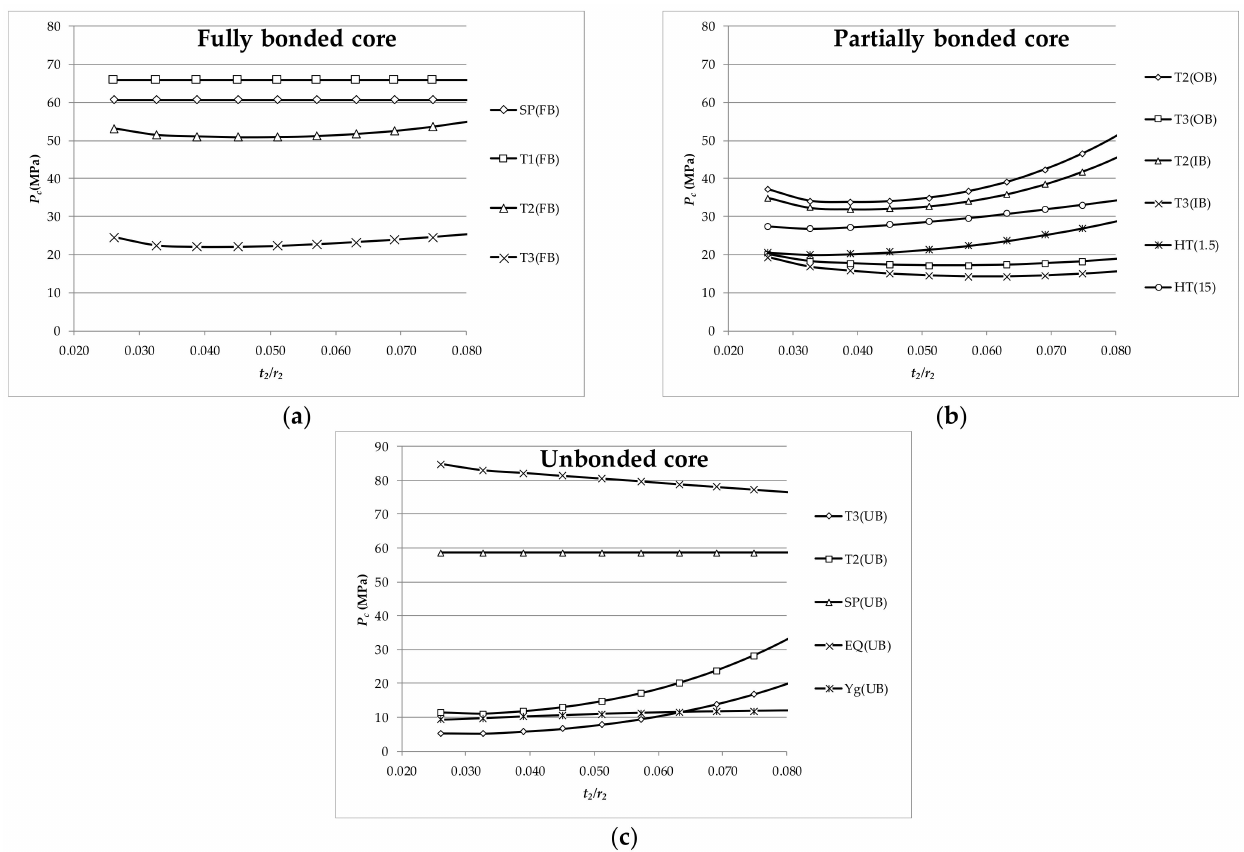
Figure 6. Variation of Pc with t 2 /r 2 ( a ) Fully bonded, ( b ) Partially bonded, and ( c ) Unbonded